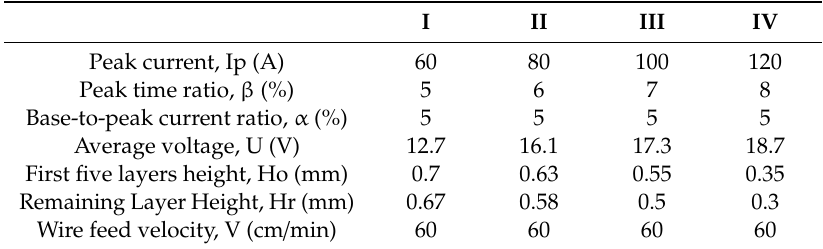
Table 4. Four groups’ deposition parameters concerning di ff erent heat